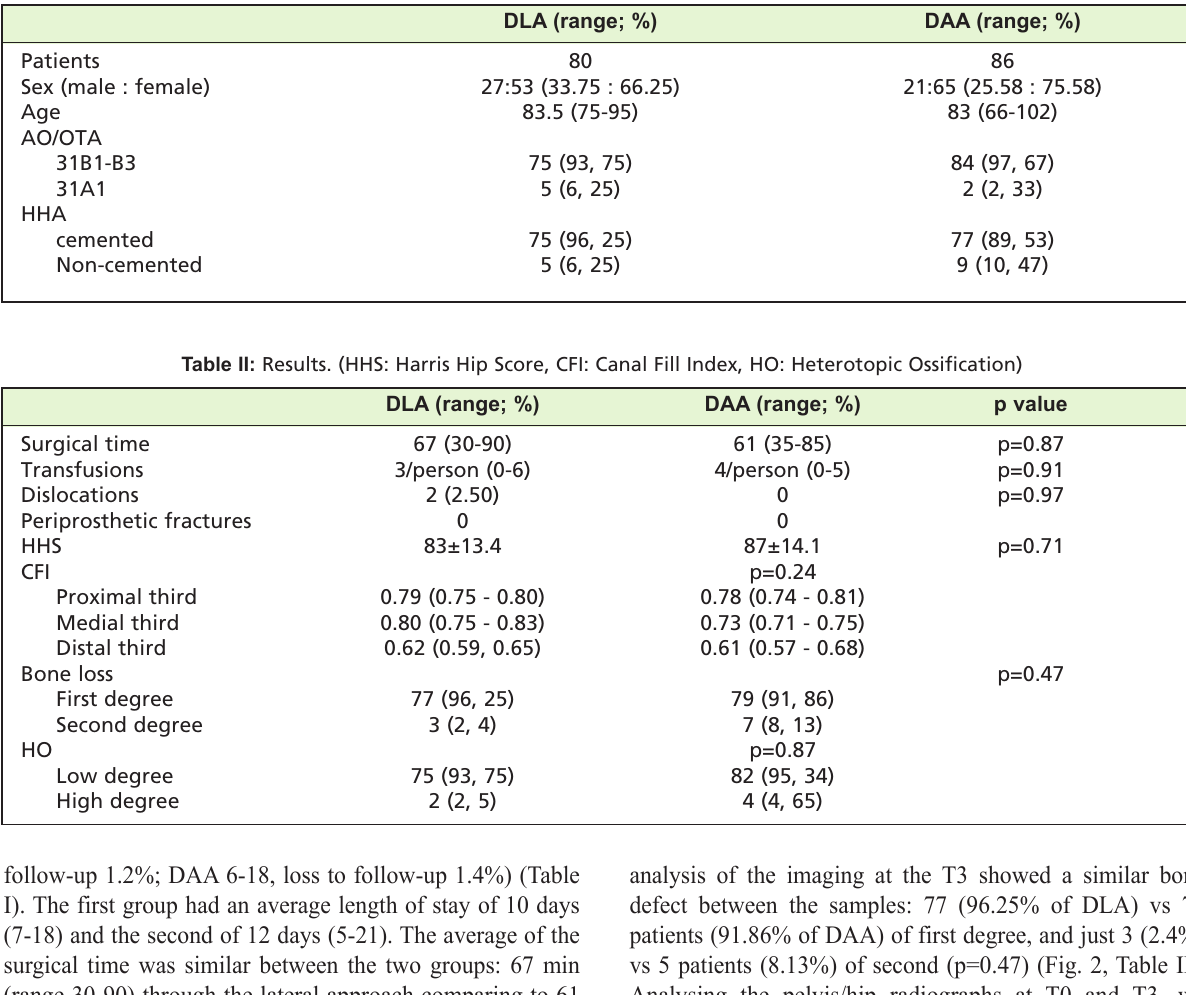
Table I: Demographic and clinical sample characteristics